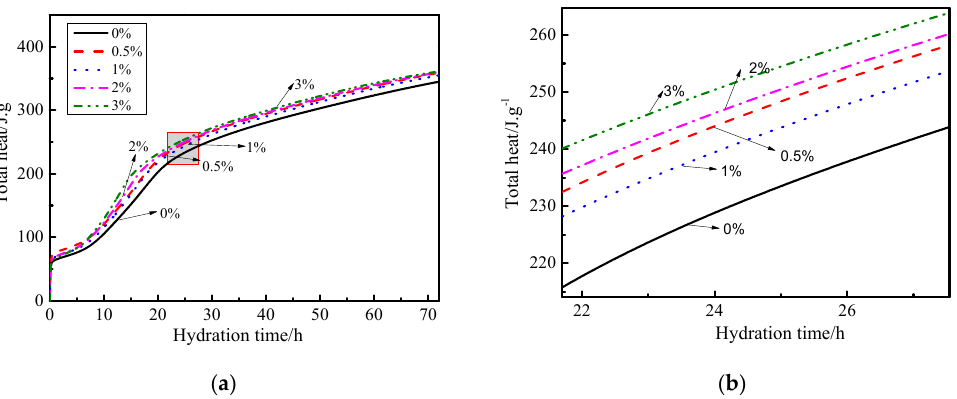
Figure 6. ( a ) Accumulated hydration heat of cement paste with different amounts of nano C-S-H addition; ( b ) Local enlarged view. Table 3. Results of Accumulated Hydration Heat.